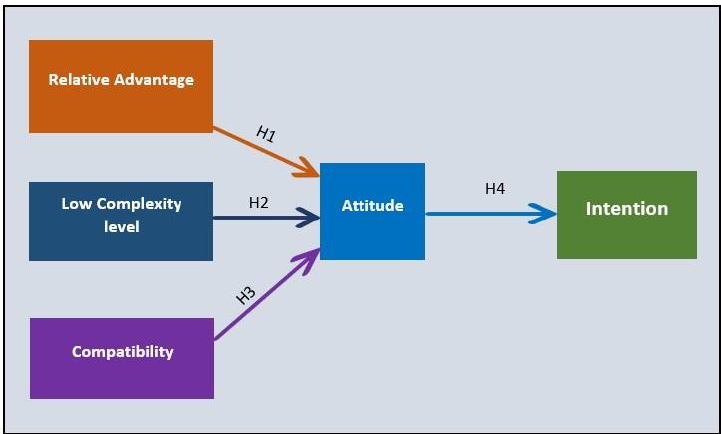
Figure 1. Conceptual